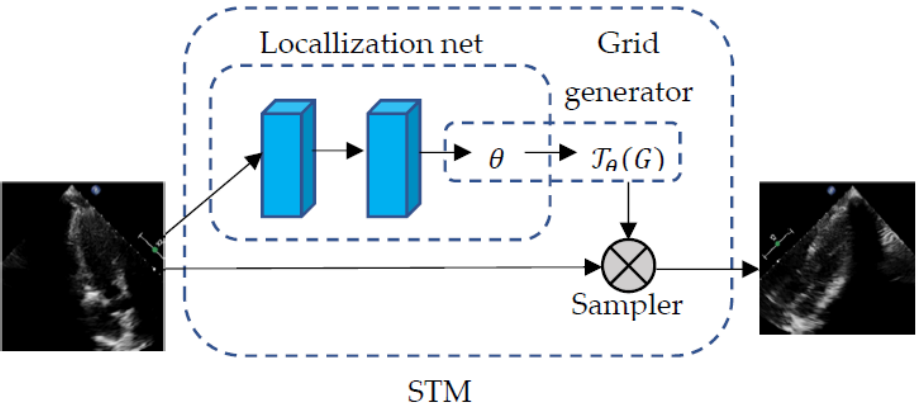
Figure 2. The flowchart of spatial transformer network. STM receives original images and uses a localization network to learn the parameters of the geometric transformation during the cardiac cycle. This network consists of two layers. First, the convolution layer of 5 5 filters is used to output 128 feature maps, followed by a global averaging layer and a fully connected layer. The localization network produces 6 parameters of affine transformation. The transformation parameters are in turn applied to every inputted image to perform a geometric transformation and reduce cardiac defor- mations.